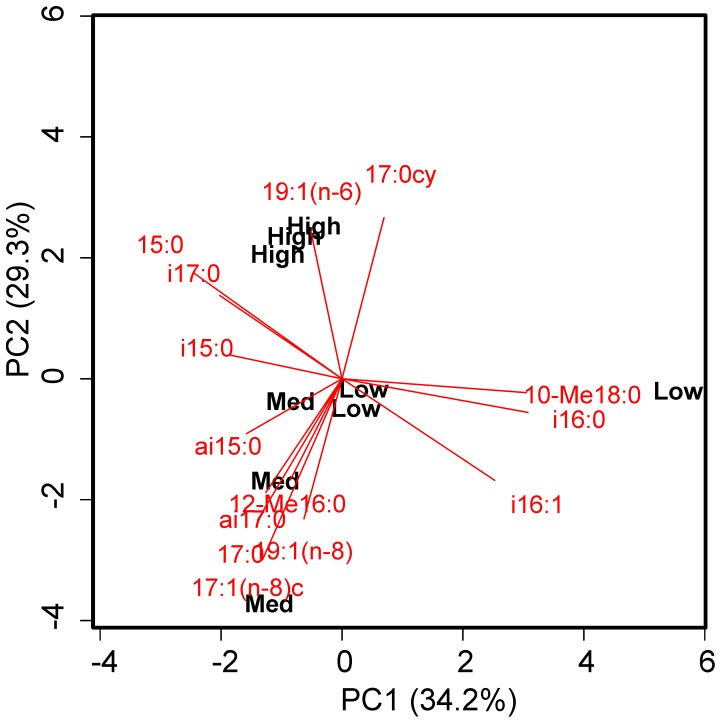
Influence of resource availability on carbon uptake into individual phospholipid fatty acids.Principle components analysis distance biplot visualising differences in the proportional uptake of 13C into the phospholipid fatty acids between the different treatments.